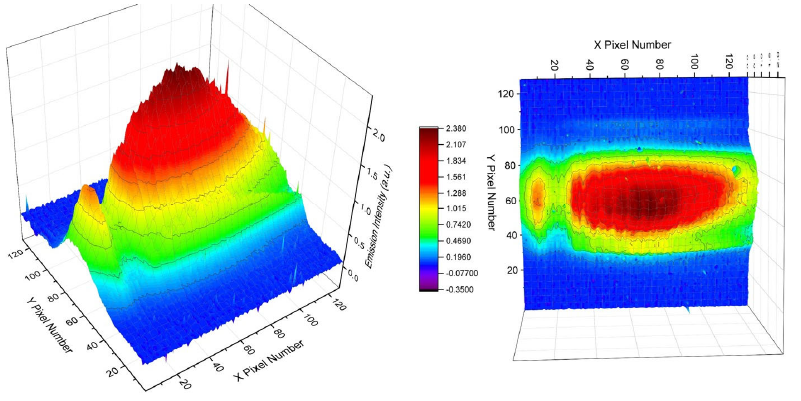
Figure 10. Infrared emission image from a 700 °C thermal radiation source on a PhaseTech 2 − D detector array.